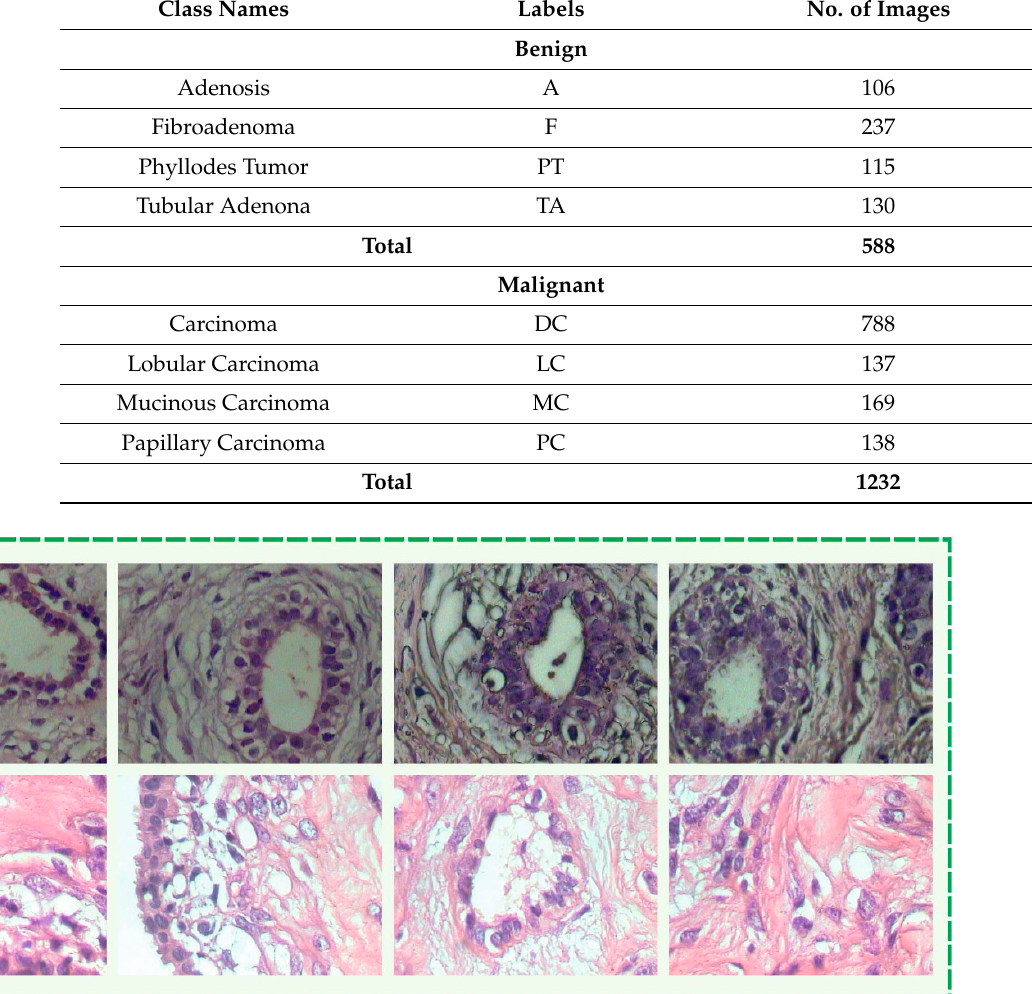
Table 1. Dataset details